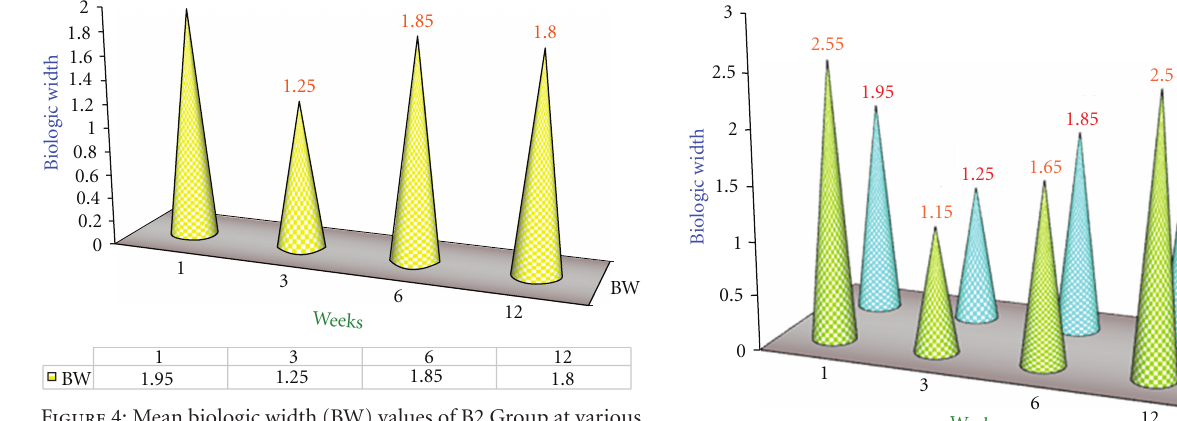
Figure 4: Mean biologic width (BW) values of B2 Group at various intervals of weeks.